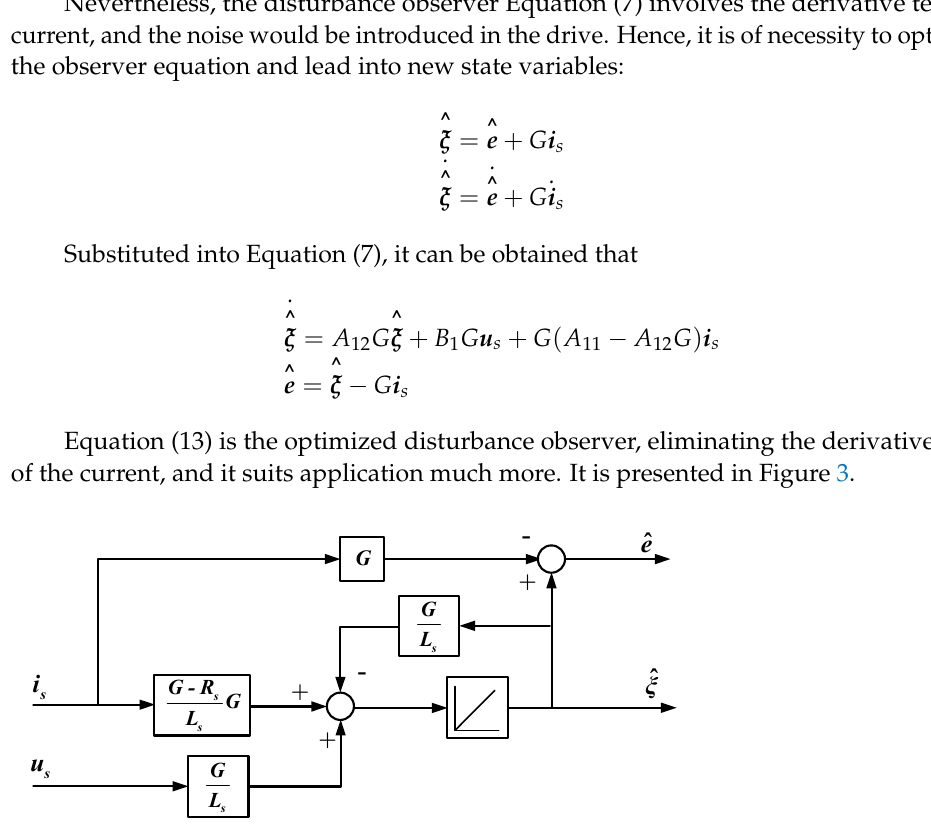
Figure 3. Diagram of disturbance observer.